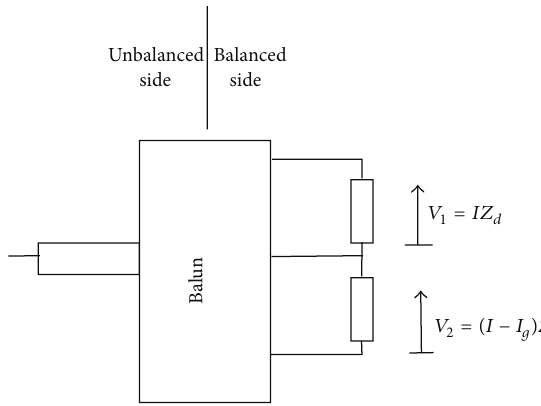
Figure 5: Equivalent circuit to evaluate the balance ratio of a balun.